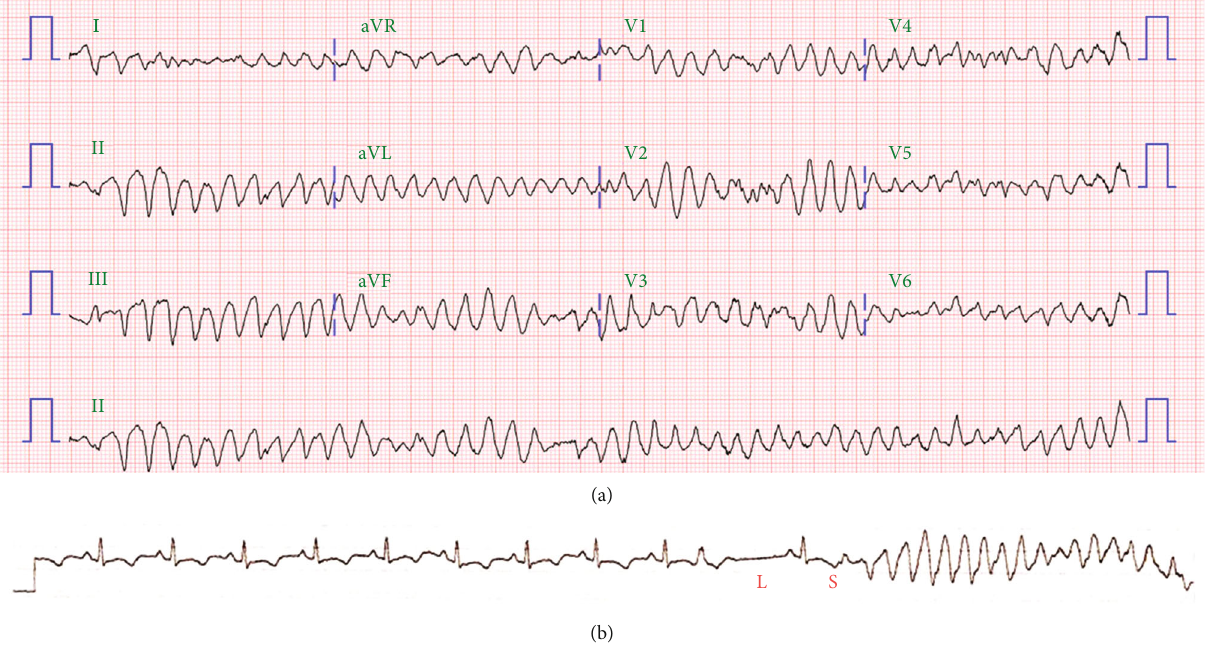
Figure 4: Polymorphic VT, (a) which starts in a pause-dependent manner with a long-short sequence and (b) is observed frequently after ROSC. Hence, the initial diagnosis is TdP following an MI. VT: ventricular tachycardia; ROSC: return of spontaneous circulation; TdP: torsades de pointes; MI: myocardial